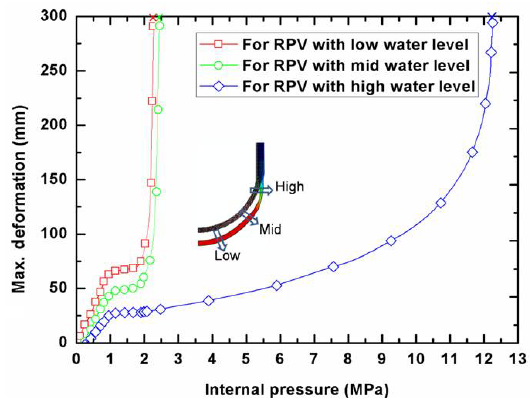
Figure 16. Relationship of deformation vs. internal pressure for RPVs with various water